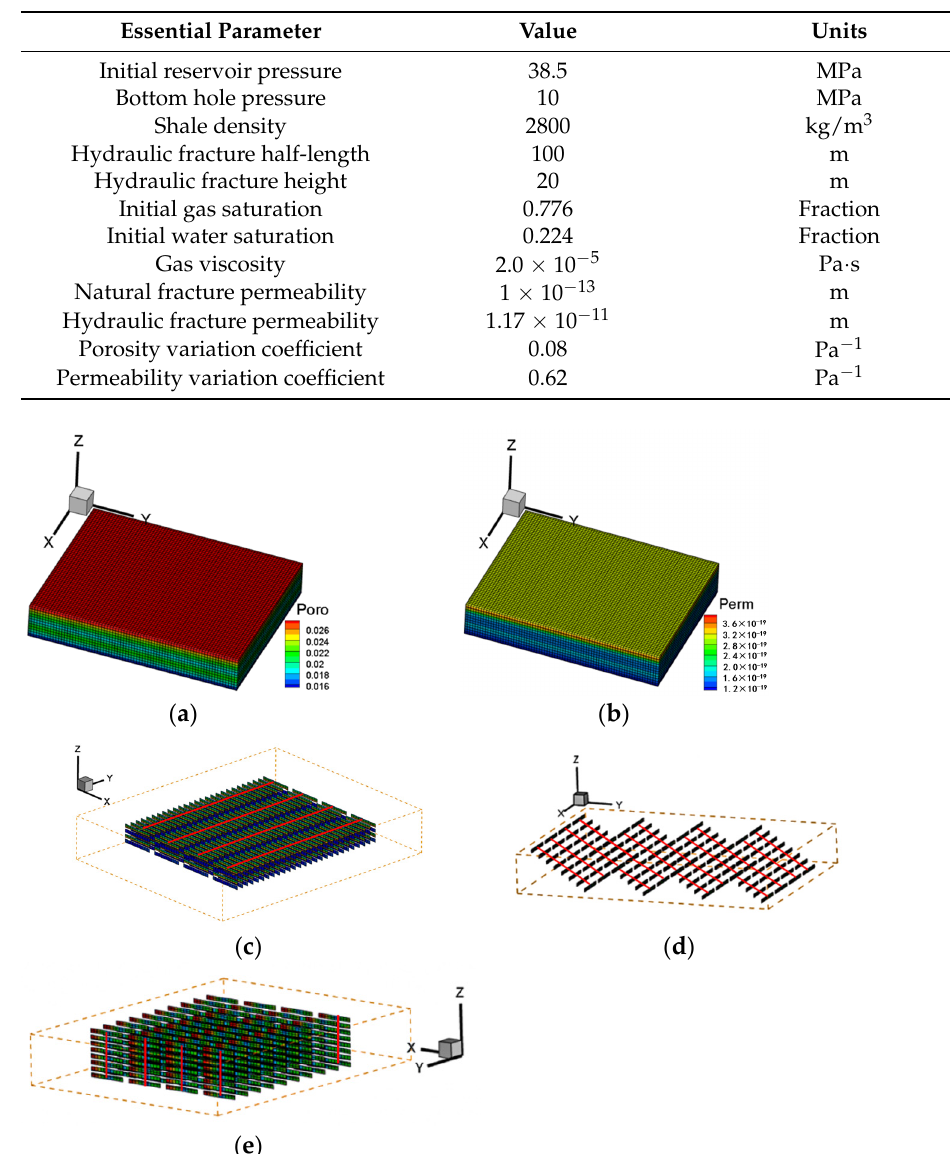
Figure 9. ( a ) model porosity field diagram; ( b ) model permeability field diagram; ( c ) horizontal well layout diagram; ( d ) deviated well layout diagram; ( e ) vertical well layout diagram.